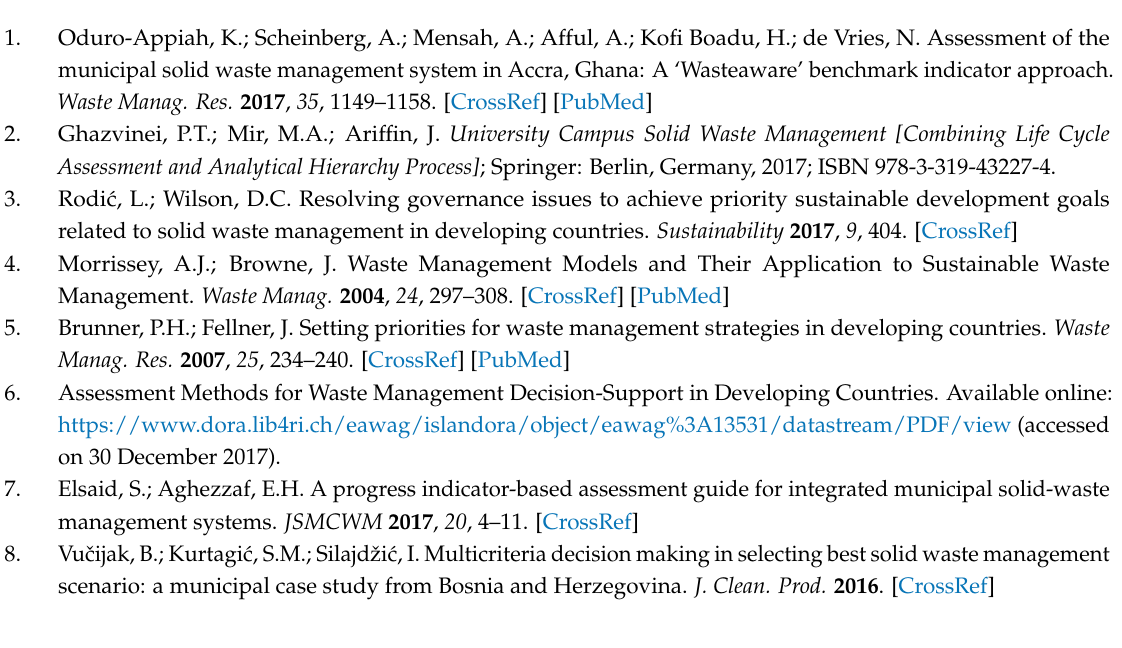
Figure S1: Mass flow diagram of Baseline Scenario; Figure S2: Mass flow diagram of AD Scenario; Figure S3: Mass flow diagram of MBT Scenario; Figure S4: Mass flow diagram of Incineration Scenario; Table S1: Details of the flows of the MFD of Baseline Scenario; Table S2: Details of the flows of the MFD of AD Scenario; Table S3: Details of the flows of the MFD of MBT Scenario; Table S4: Details of the flows of the MFD of incineration Scenario. Author Contributions: N.T. realized the interviews and wrote the paper. A.V.M. conceived and supervised the study. A.A.C.S. contributed in the data